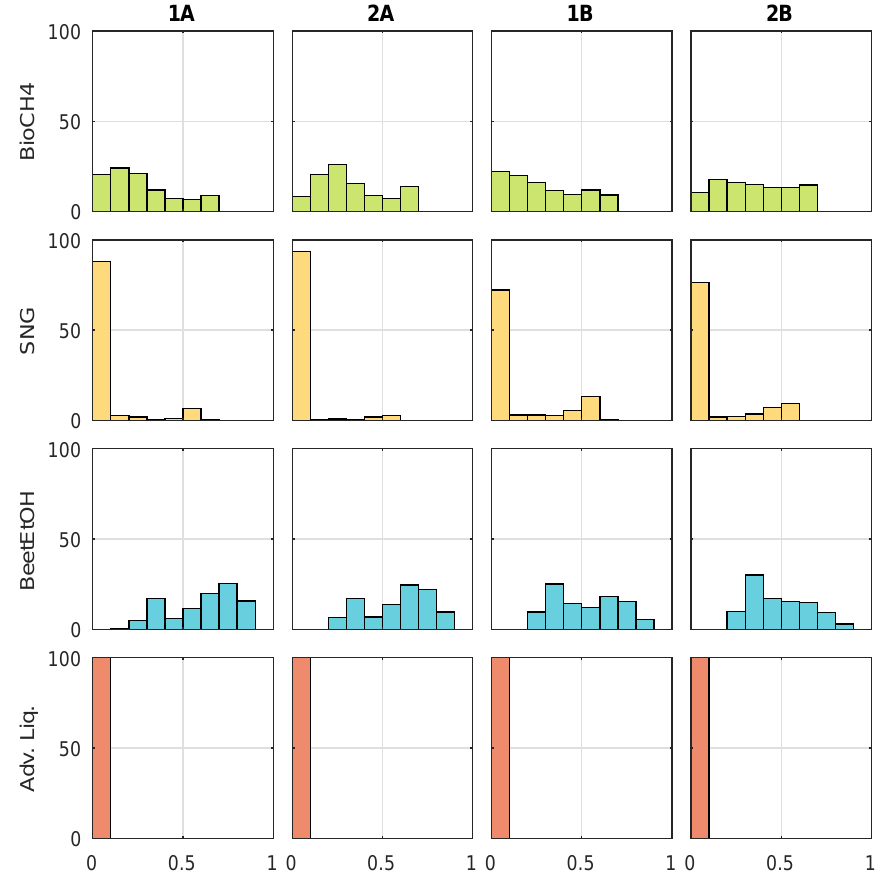
Figure 8. Sensitivity of biofuel production shares, at annual 3% (1) and 4% (2) wheat price increases, with moderate (A) and more progressive (B) power mix developments. 2A and 2B correspond to the sensitivities within Scenarios (a) and (b). The share (%) of the occurrences among the 1000 runs at total cumulative biofuel shares (on an energetic basis) of between 0% and 10%, 10% and 20% etc., are shown in the histogram. The shares are of the total cumulative biofuel deployment over the whole time span. For the upper three, all fuels were included, whereas for advanced liquid fuels, only liquid biofuels were